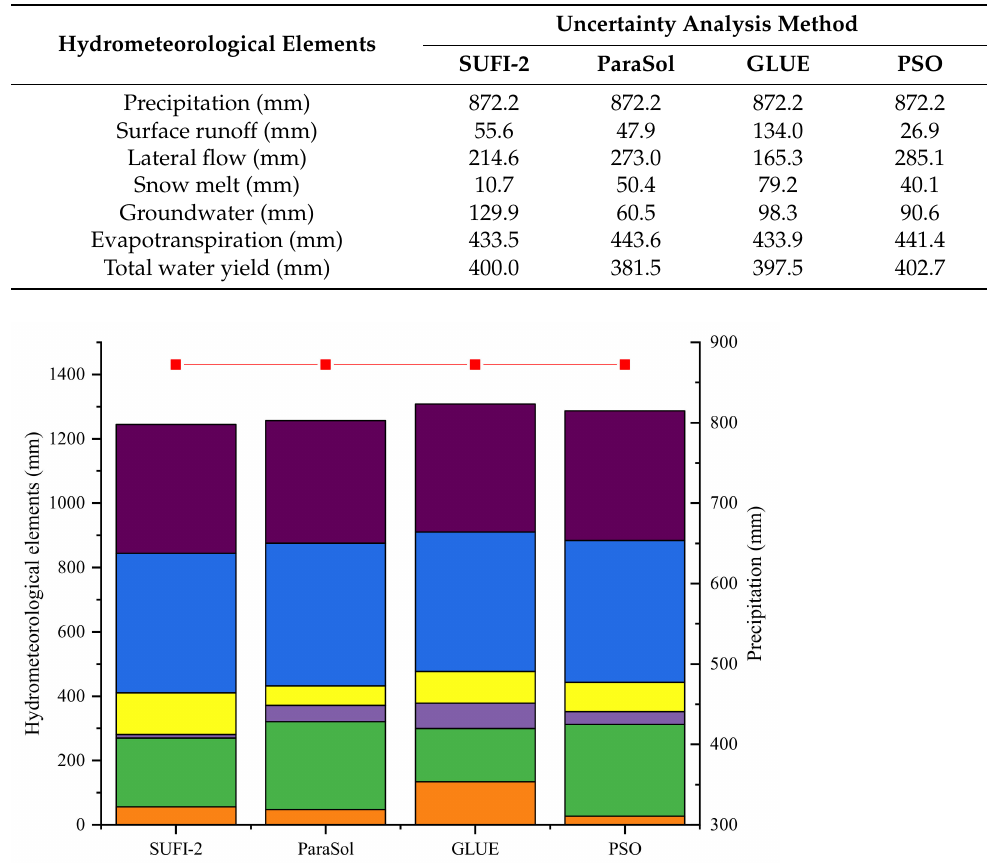
Table 8. Average contributions of different hydrometeorological components to the water balance.